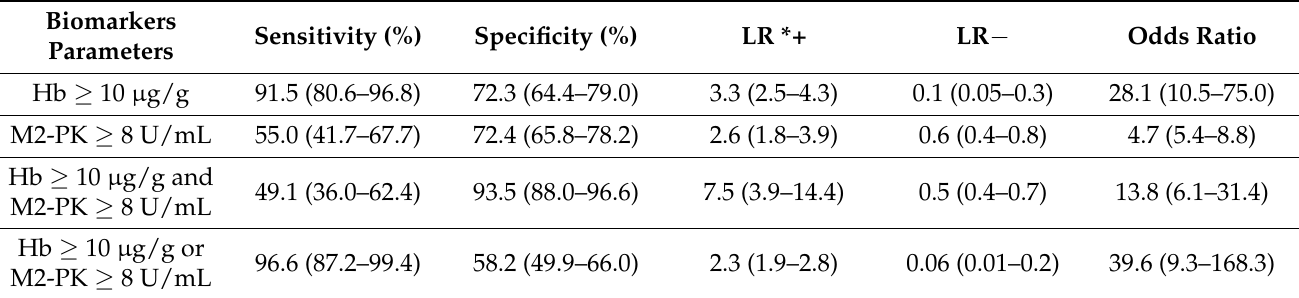
Table 3. Evaluation of the accuracy of the evaluated strategies for significant diagnosis of CRC.